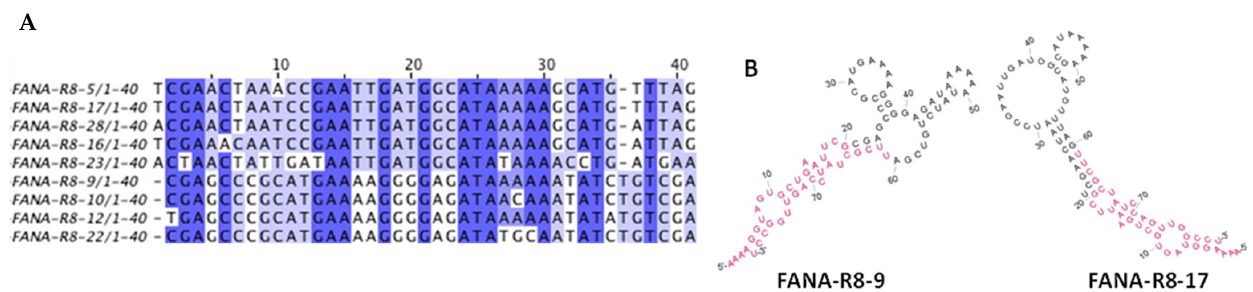
Figure 2. Sequence alignment using the MAFFT program for the random region (nucleotides 1–40) of recovered ap- tamers in the FANA-R8–17 and FANA-R8–9 lineages: ( A ) FANA-R8–5 to FANA-R8–23 are from the lineage contain- ing FANA-R8–17, and FANA-R8–9 to FANA-R8–22 are from the FANA-R8–9 lineage. The fixed primer regions 5’- AAAAGGTAGTGCTGAATTCG-3 (cid:48) at the 5 (cid:48) end and 5 (cid:48) -UUCGCUAUCCAGUUGGCCU-3 (cid:48) at the 3 (cid:48) end are not shown in the alignment; ( B ) RNAfold program predicted structures of FANA-R8–9 and 17. Folded aptamers include primer regions. Red nucleotides are from the fixed primer regions at the 5 (cid:48) and 3 (cid:48) ends, while black nucleotides were derived from the random region of the starting material. Table 1. Apparent equilibrium dissociation constants (K D ,app) for tested FANA aptamers.